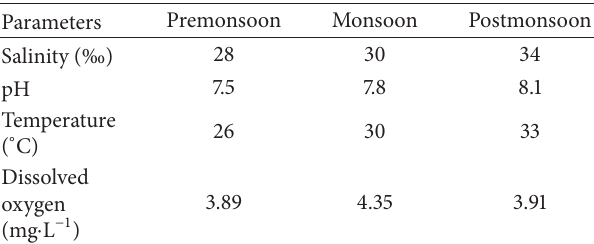
Table 4: Physicochemical properties of the water in the creek.